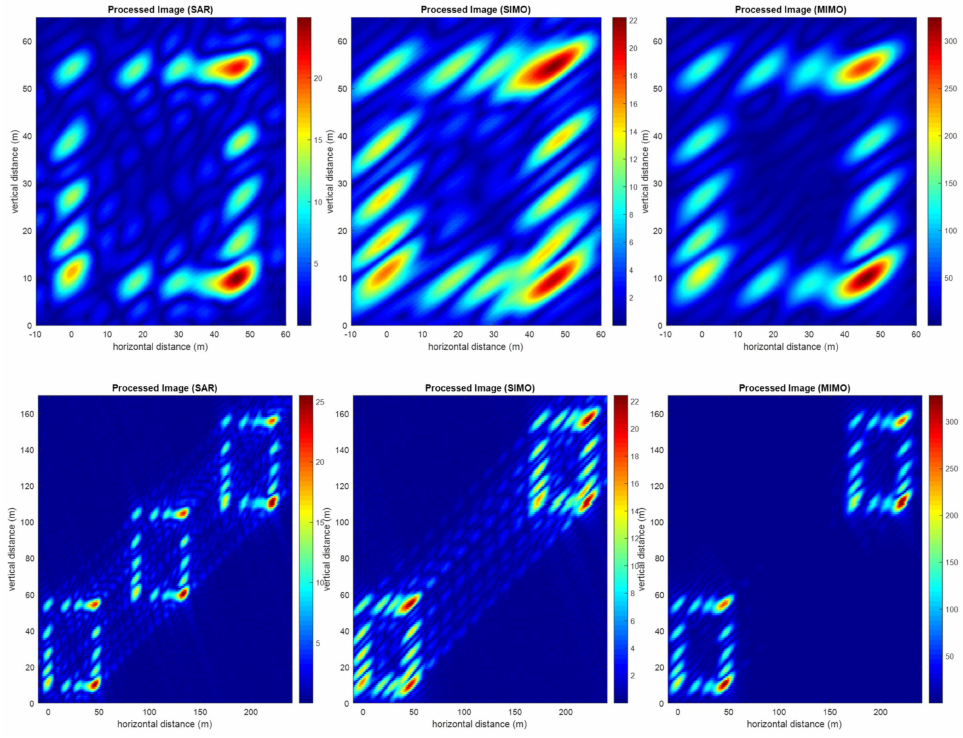
Figure 22. The simulated 2D images for Example 1 for SAR/SIMO/MIMO modes. Upper row: fine scene resolution (20 cm), small scene extent. Lower row: coarse scene resolution (1 m), large scene extent.